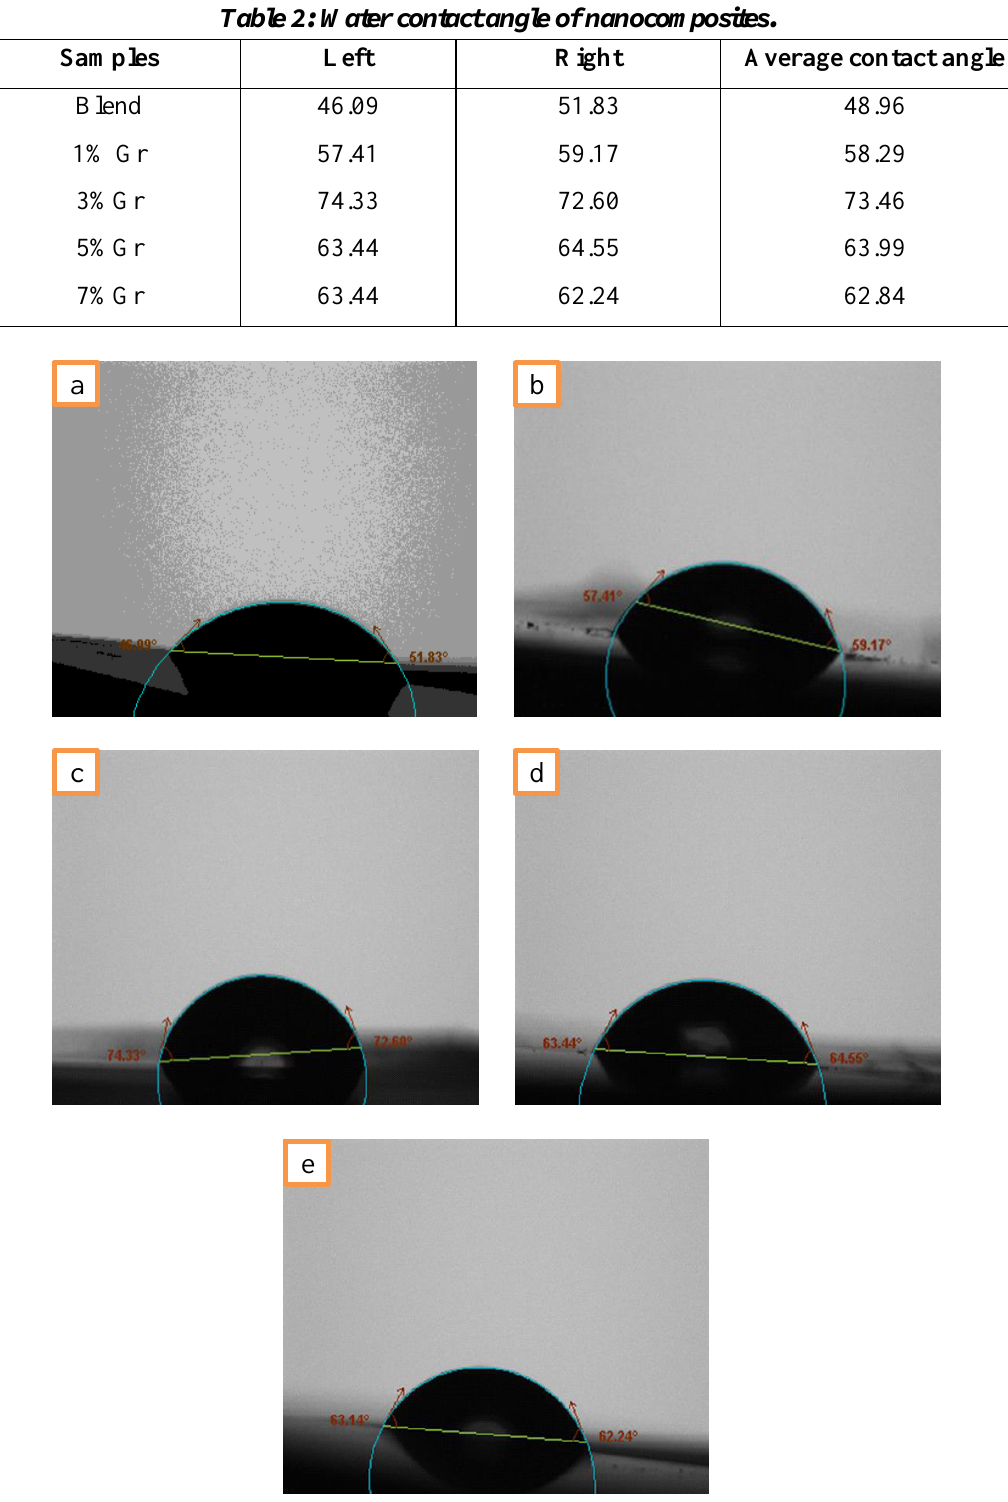
Table 2: Water contact angle of nanocomposites.